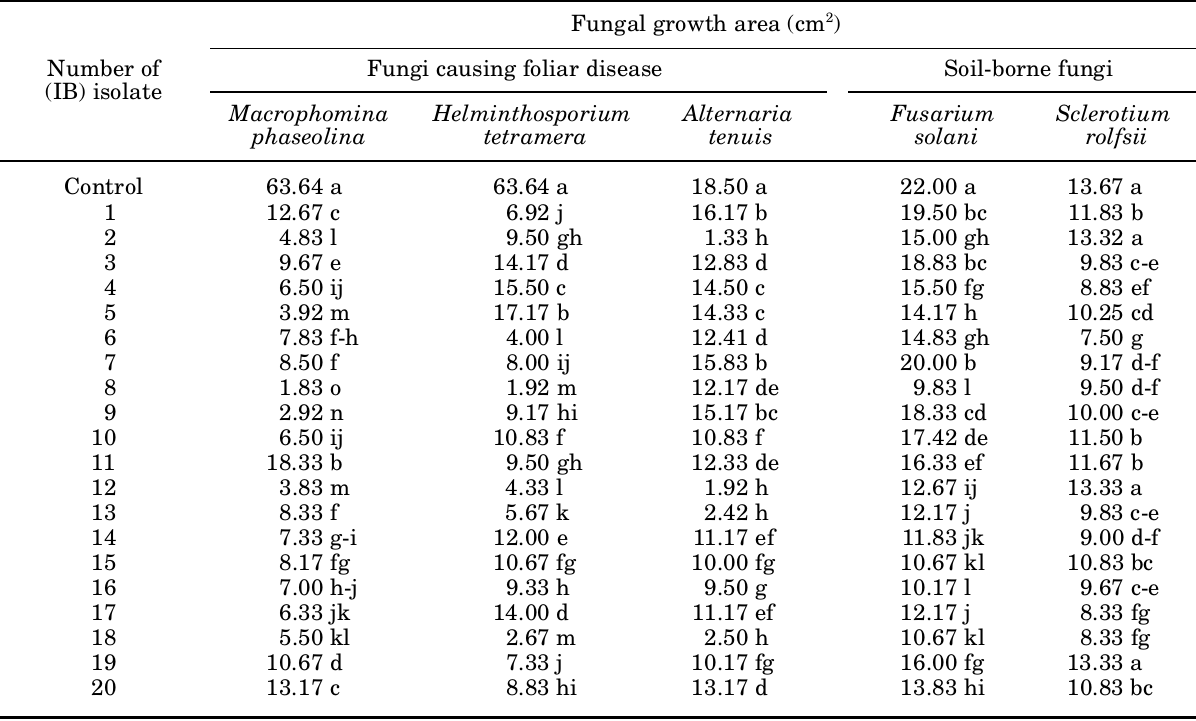
Table 2. Inhibition of fungal pathogens by 20 bacterial isolates from the phylloplane of Ipomoea batatas (IB).